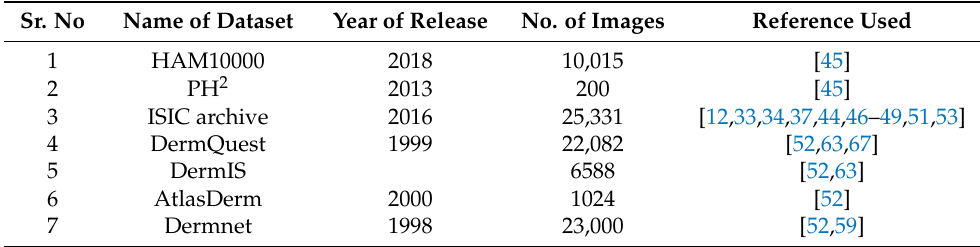
Table 9. Skin Cancer